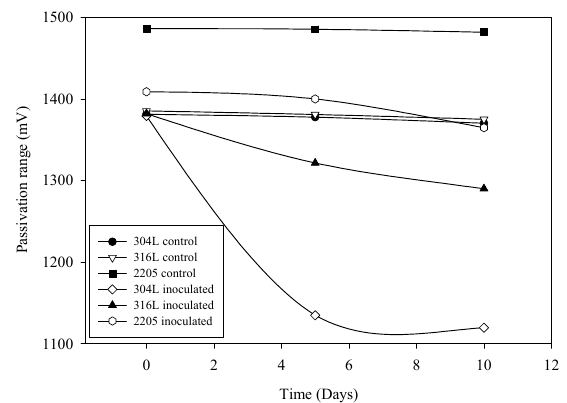
bacteriaTime Fig. 11 Passivation range of stainless steels in media with/without Figure 11. Passivationrangeofstainlesssteelsinmediawith/without bacteria.